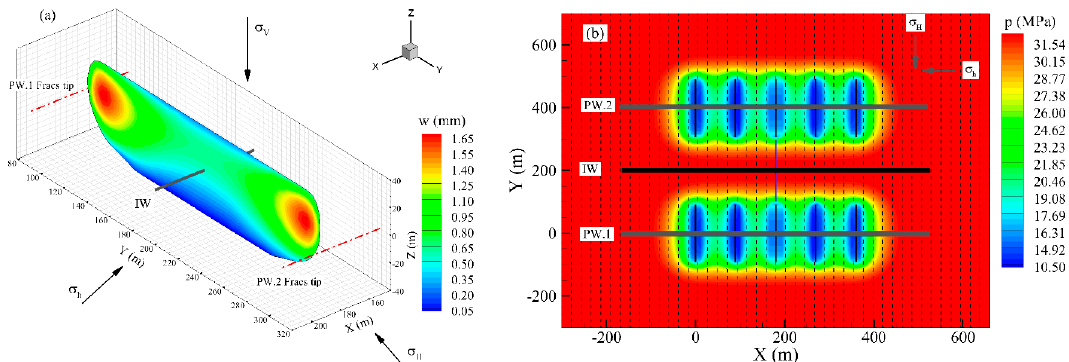
Figure 22. Infill well fracture propagation before repressurization of the production well fractures in the strike-slip stress regime after 3 years of production: ( a ) generated fracture geometry, ( b ) plan-view of the propagated fracture geometry on top of the reservoir pore pressure plot. The Infill well fracture shows more growth towards production wells due to reduced stress zones, and in the upward vertical direction (i.e., along Z -axis) due to the in situ stress gradient effect.